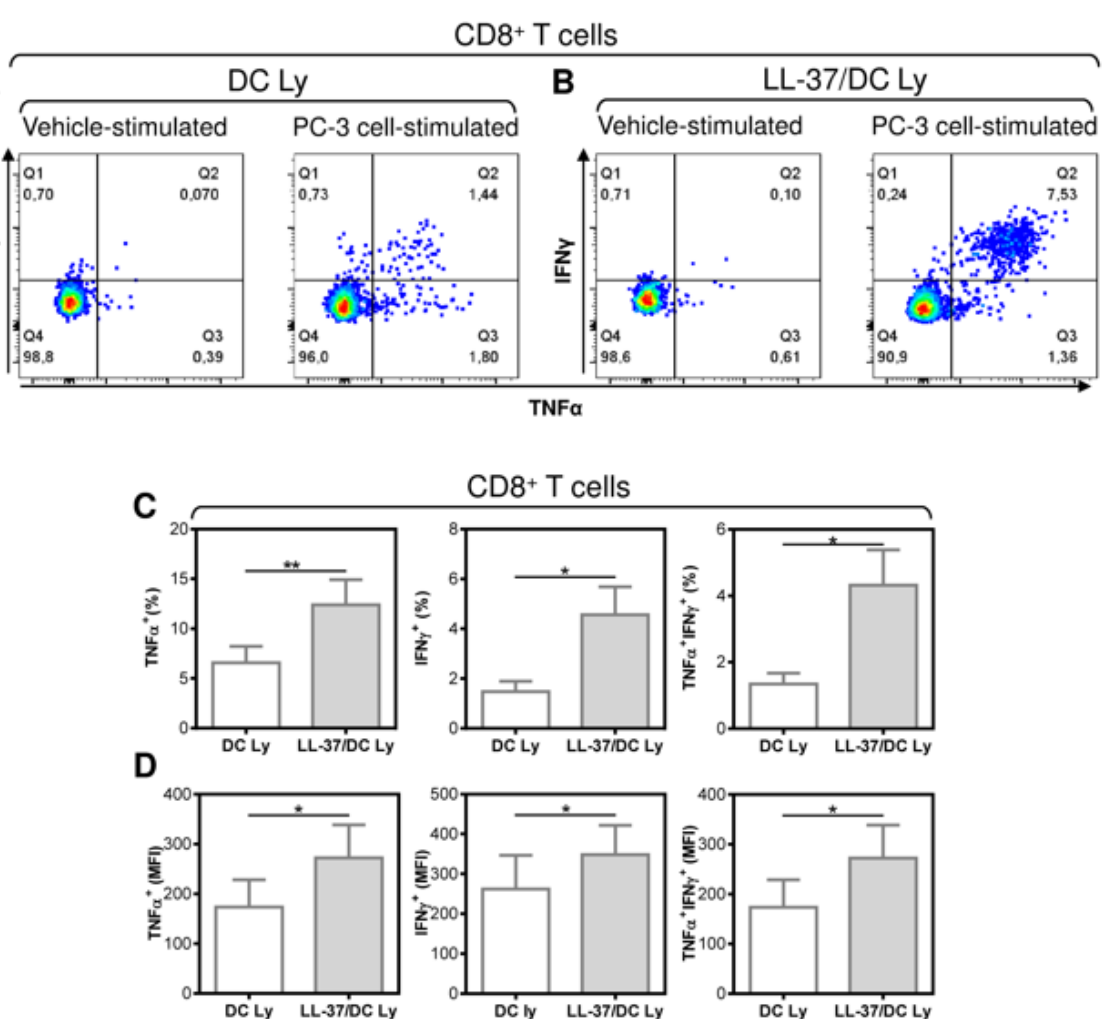
Figure 4. The application of LL-37 during DC production (differentiation, pulsation, and maturation) significantly enhanced the enrichment of DC-stimulated autologous lymphocytes with tumor-cell-specific CD8 + T cells. The 14-day autologous lymphocytes stimulated with DCs (DC Ly) or DCs produced in the presence (differentiation, pulsation, and maturation) of LL-37 (LL-37/DC Ly) were re-stimulated with live PC-3 cells at the ratio of 5:1 (lymphocytes/PC-3 cells), and the frequency of TNF- α -, IFN- γ -, and TNF- α /IFN- γ -producing CD8 + T cells was determined by intracellular cytokine staining using flow cytometry. ( A , B ) The gating strategy of CD8 + T cells was as in Figure 1B and was followed by the gating of the cytokine-producing CD8 + T cells in vehicle- (vehicle-stimulated) or PC-3 cell (PC-3 cell-stimulated)-stimulated DC Ly ( A ) and LL-37/DC Ly ( B ) samples. ( C ) The frequency of TNF- α - (left panel), IFN- γ - (middle panel), and TNF- α /IFN- γ (right panel)-producing CD8 + T cells was determined by intracellular cytokine staining in DC Ly- and LL-37/DC Ly samples. ( D ) The mean fluorescence intensity (MFI) of TNF- α - (left panel), IFN- γ - (middle panel), and TNF- α /IFN- γ (right panel)-producing CD8 + T cells was determined by intracellular cytokine staining in DC Ly and LL-37/DC Ly samples. In ( C , D ), mean + SEM and significances of differences between the group of DC Ly and LL-37/DC Ly samples are indicated (* p < 0.05, ** p < 0.01; ( C ) n = eight donors, ( D ) n = six donors; paired two-tailed Student’s t